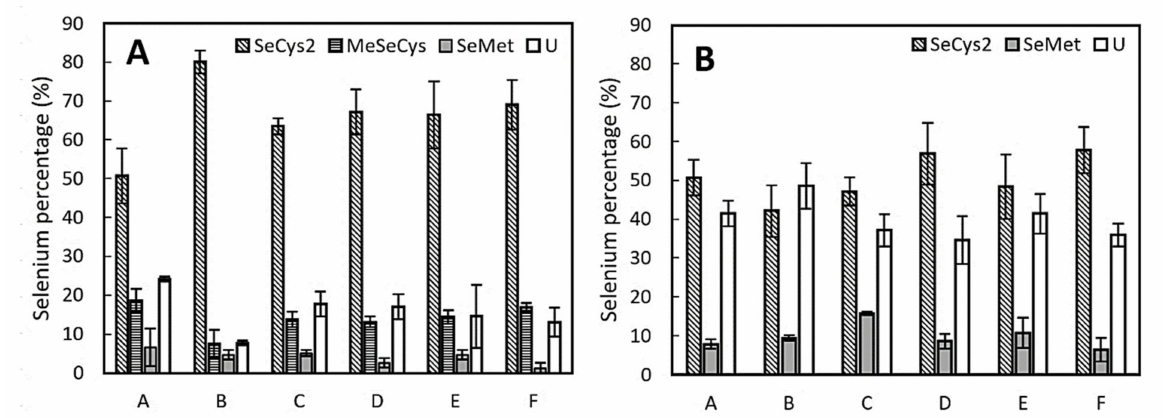
Figure 4. Selenium species representation expressed as a percentage of the total selenium content: ( A ) kidneys and ( B ) liver. The error bars indicate the standard deviation ( n = 2). SeCys2 (selenocysteine), MeSeCys (Se-methylselenocysteine), SeMet (selenomethionine), and U (sum of unidentified